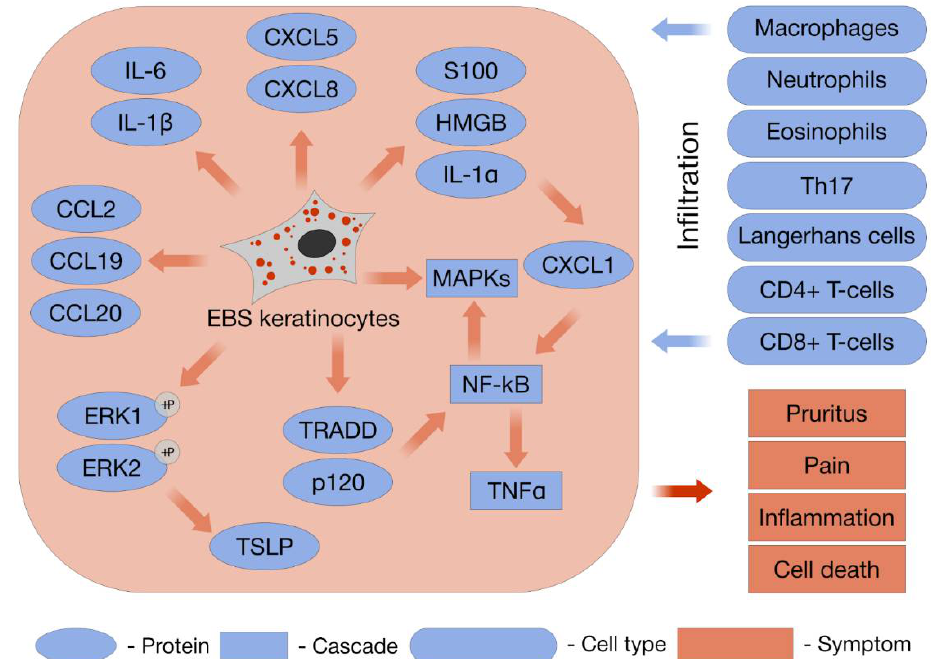
Figure 6. Scheme of key inflammatory participants in EBS skin. Aberrations in the keratin network of EBS keratinocytes activate stress signaling and trigger inflammatory and apoptotic signaling pathways, which lead to the secretion of pro-inflammatory agents. Acting through positive feedback mechanisms, proinflammatory agents contribute to the infiltration of different immune cells in the areas of EBS skin blistering [11,125]. This results in increased cell death, pruritus, and pain and induces chronic inflammation. IL-6/1 β /1 α —interleukins 6/1 β /1 α [126,127]; CXCL1/5/8—CXC chemokine ligand 1/5/8 [125]; S100—S100 proteins; HMGB—high-mobility group box [9]; MAPKs—mitogen-activated protein kinases [95]; NF-kB—nuclear factor kappa-light-chain-enhancer of activated B cells; TNF-a—tumor necrosis factor-alpha [7]; TRADD— tumor necrosis factor receptor type 1-associated DEATH domain protein [10,119]; p120—catenin delta-1 [128]; ERK1/2— extracellular signal-regulated protein kinase 1 [129]; TSLP—thymic stromal lymphopoietin [130]; CCL2/19/20—C-C motif 2 ligand 2/19/20 [126]; Th17—T helper 17 cells [131]; CD4 +T-cells—T lymphocytes with CD4 receptors; CD8+T-cells—T lymphocytes with CD8 receptors [132]. Arrows indicate activation of an expression or